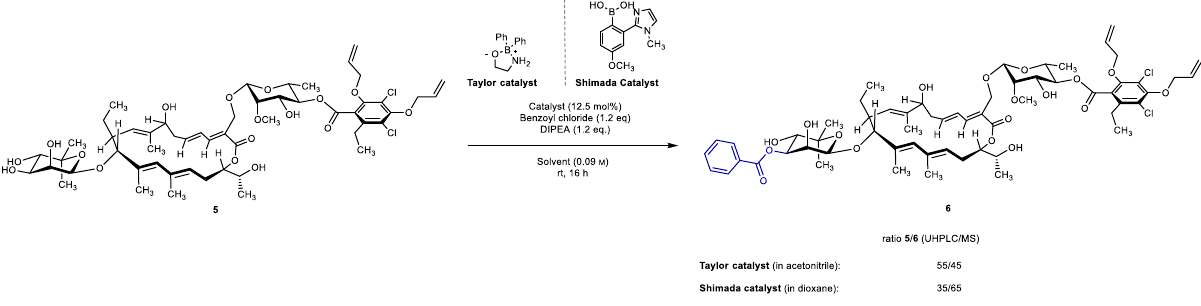
Fig. 6 C3 ” -OH acylation of 5. Initial catalyst evaluation to access C3 ” -acylated fi daxomicin